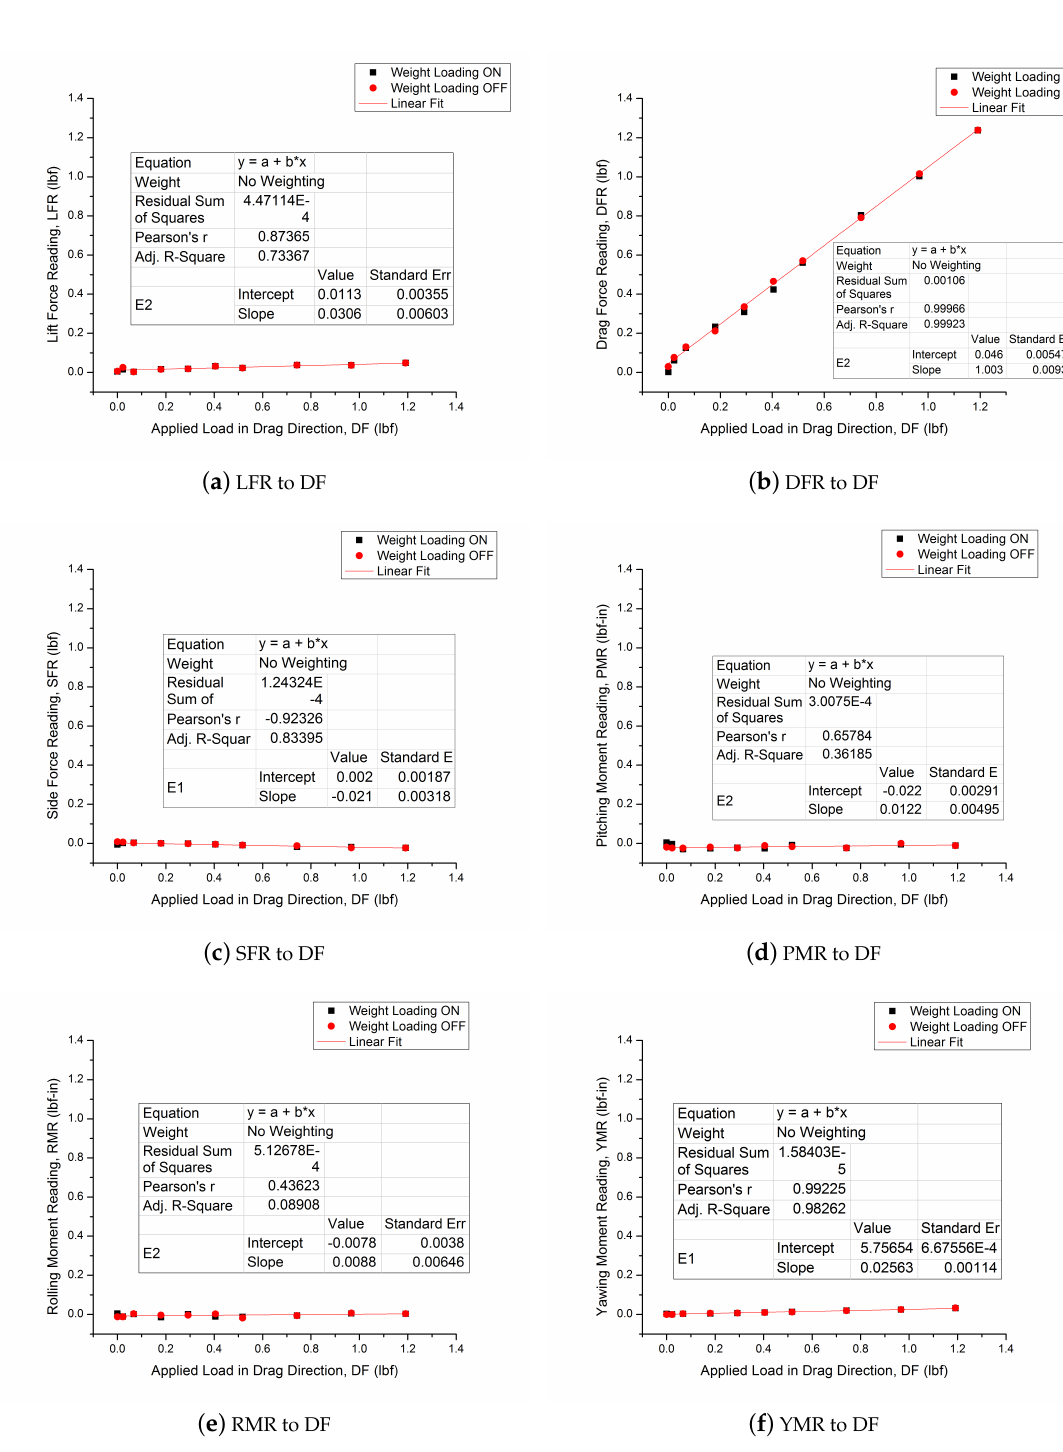
Figure A2. Experimentally obtained wind tunnel pyramidal balance interactions upon applied load in drag force